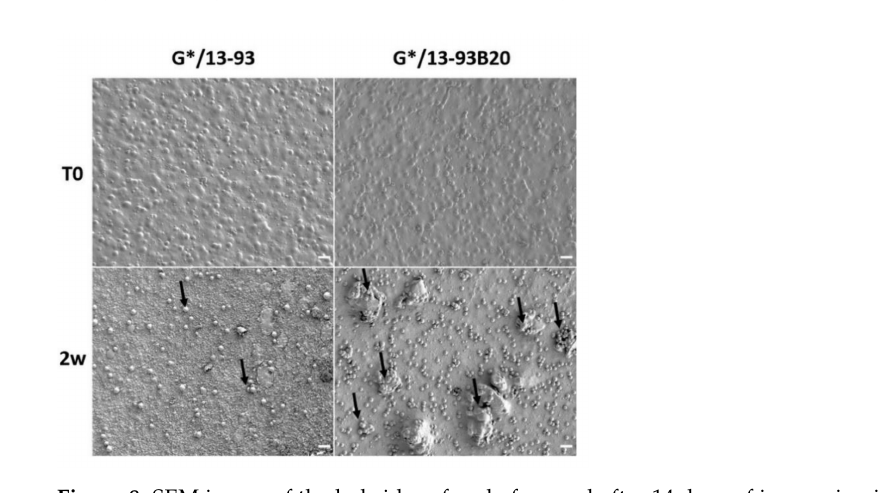
Figure 8. SEM image of the hybrid surface before and after 14 days of immersion in SBF (scale bar 20 µ